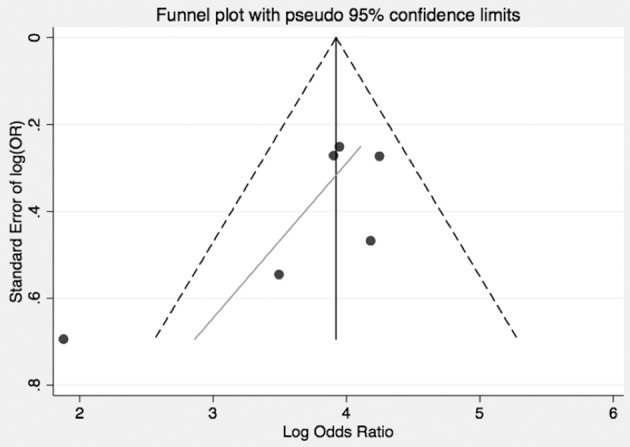
Bias and overestimation of risk impact interpretation of risk of VTE in CS from literature. Funnel plot visually representing the heterogeneity among trials reporting odds of VTE in CS. As shown, included studies are asymmetrically distributed relative to the point estimate. This suggests that pooled results are influenced both by bias and overestimate of risk in the CS population.